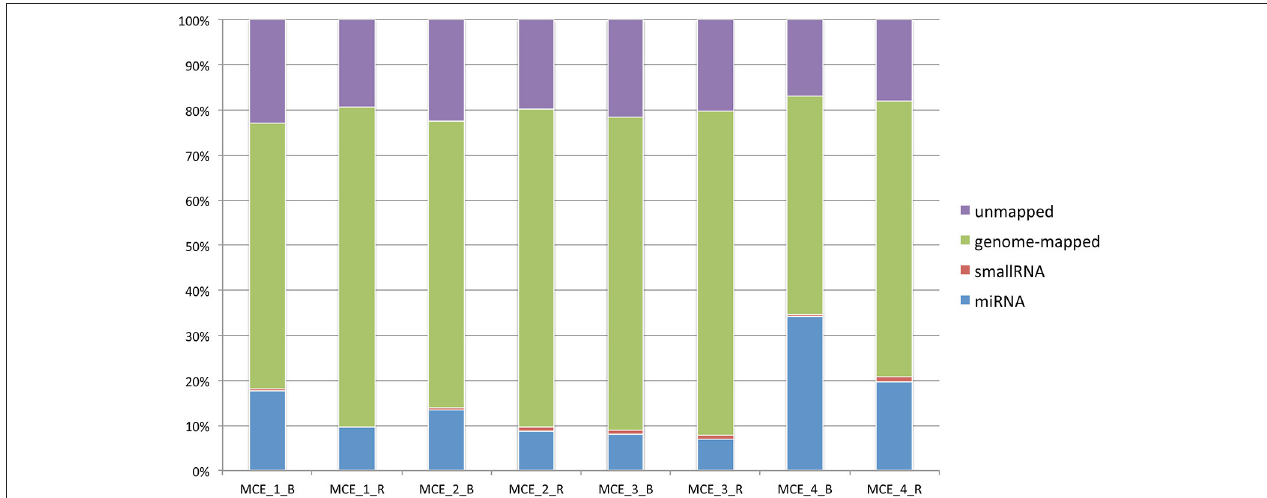
FIGURE 1 | Classification of reads per sample based on the genomic compartment and proportion of mapped/unmapped sequences.